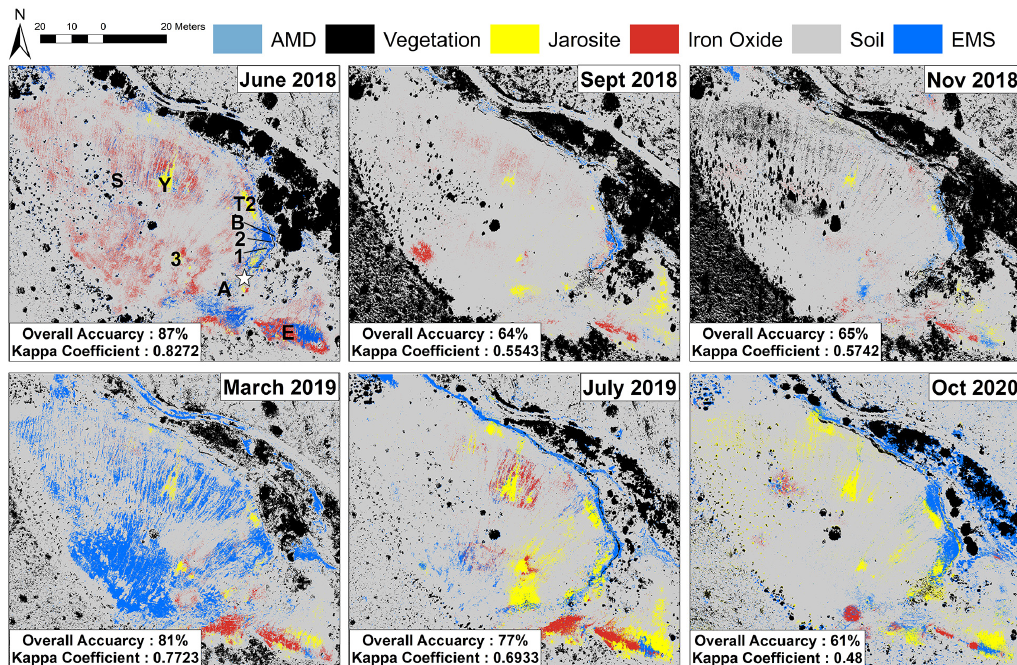
Figure 6. Results of Maximum Likelihood Classification for each remotely piloted aerial system survey. Overall Accuracy for all six surveys is 72.5%, with a Kappa Coefficient of 0.6502. Locations for ground surveys are indicated on the June 2018 map for Y, T2, B, A, E, S, and Transects 1–3 (1,2,3), and the adit drain is indicated with a star. Each scene is 240 m wide and 184 m tall.